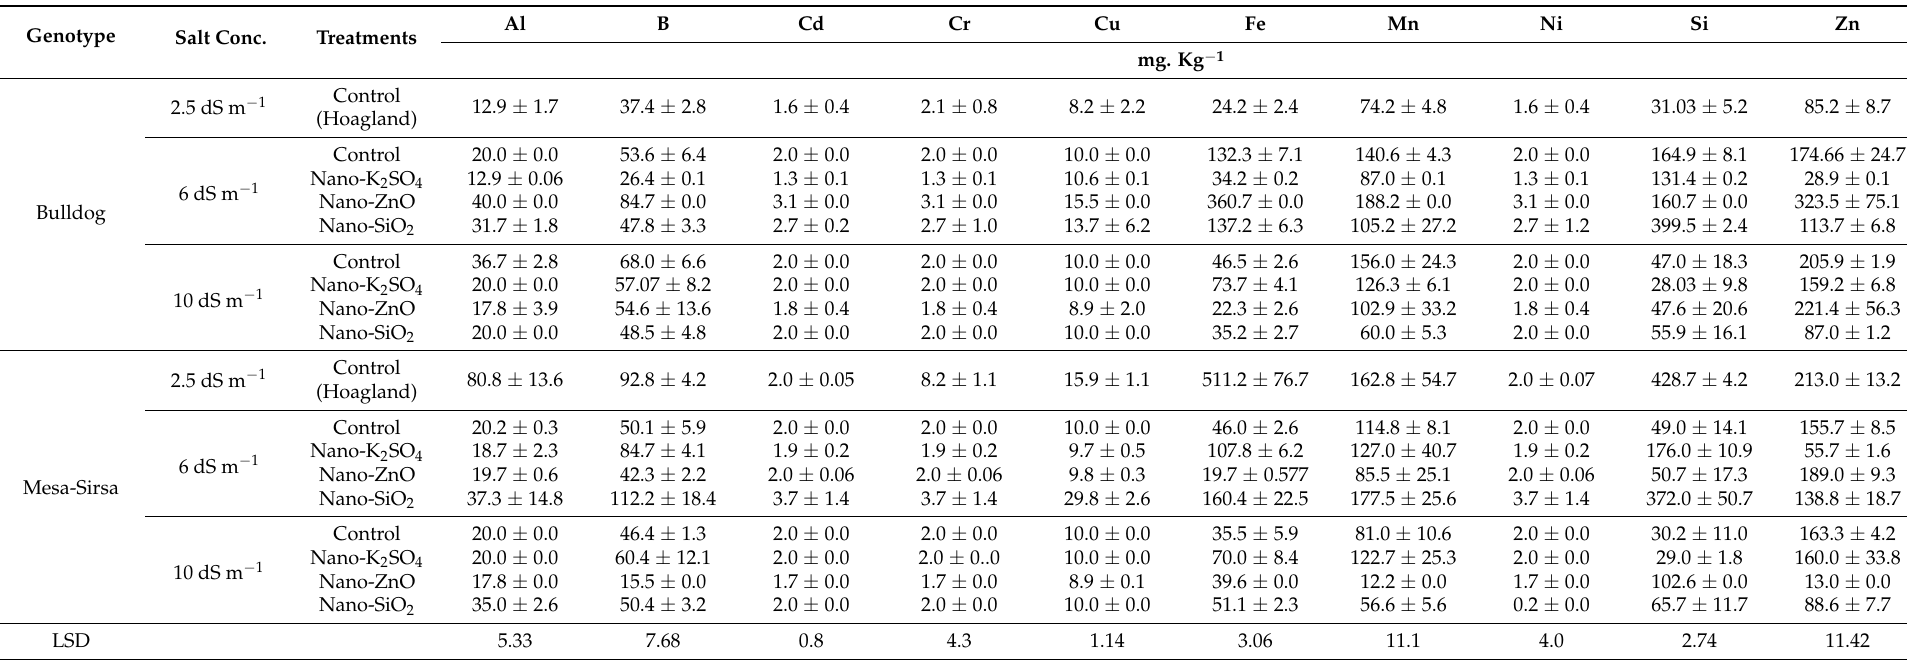
Table 5. Micro-elements in plant tissue of two alfalfa genotypes as affected by three salt levels (0, 6, and10 dS m − 1 ) and different nano-fertilizers (K 2 SO 4 , ZnO, and SiO 2